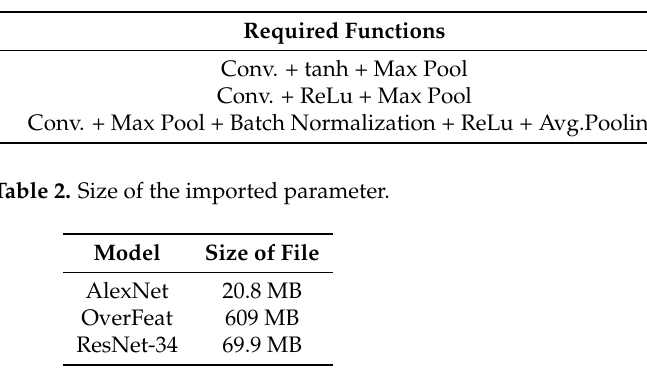
Table 1. Deep models used for the implementation.